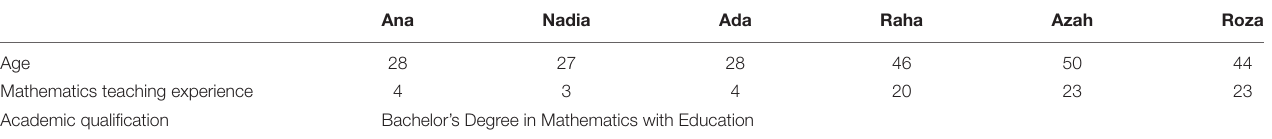
TABLE 2 | Educational background and the teaching experience of the research